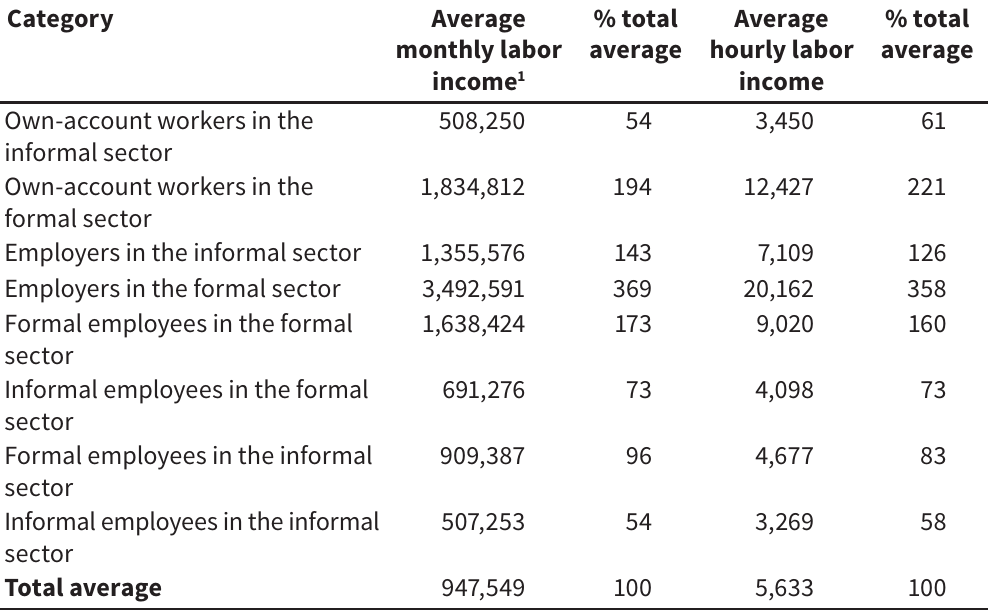
Average earnings by occupational position and informality